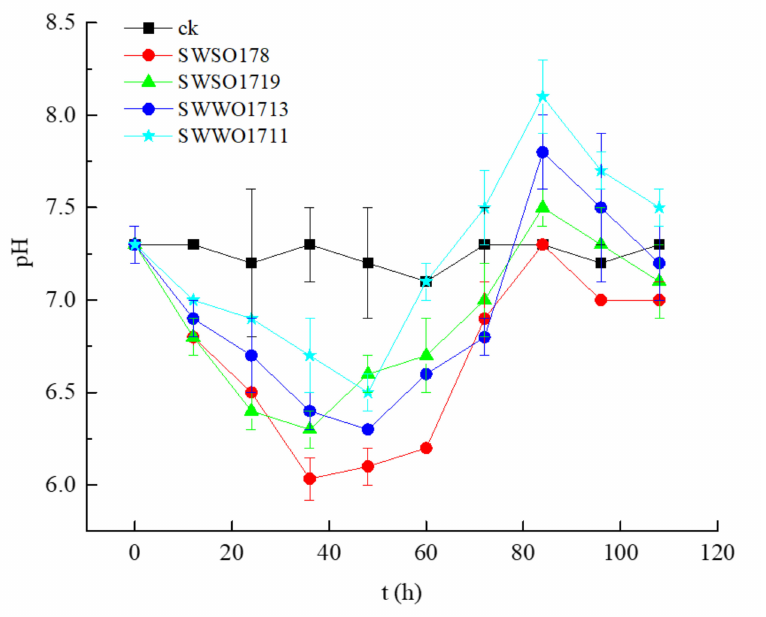
Figure 4. pH variation in the culture of four representative bacteria strains. Note: growing broth at 28 ◦ C after 12, 24, 36, 48, 60, 72, 84, 96, and 108 h of growth. Each value is a mean of three independent replicates. Control: uninoculated